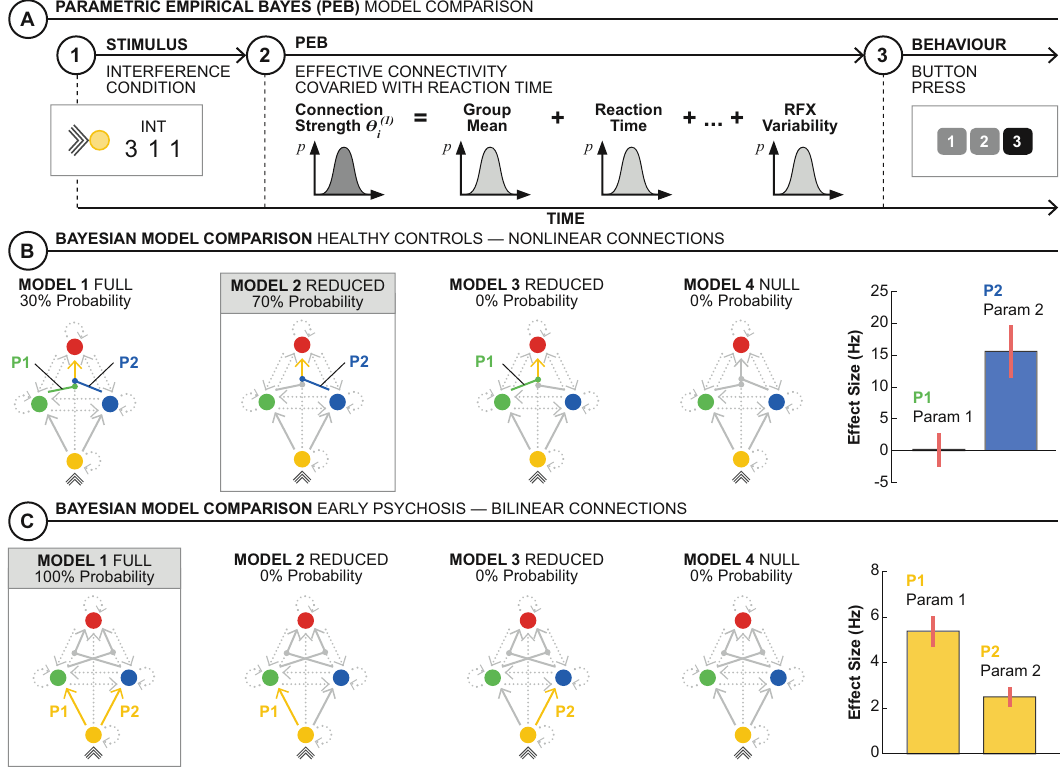
Fig. 3 Individual differences in effective connectivity and reaction time. A PEB was used to model the effect of interference condition on effective connectivity on the optimal model for each group (as derived from the BMS) and its dependence on reaction time (i.e., time from stimulus onset to button press) using a random-effects analysis. B For controls, the gated modulation of SPC on the VC to AI connection explained most of the individual differences in reaction time with a large effect size (posterior estimate 15.6 Hz). The reduced model containing this gated modulation was the most probable model to explain individual differences in reaction time (posterior probability 70%). C For EP participants, the linear, additive modulations from VC to ACC and VC to SPC explained most of the reaction time variance within group with moderate effect sizes (posterior estimate 5.4 Hz and 2.5 Hz, respectively). The full model containing both these linear, additive modulations was the most probable model to explain individual differences in reaction time (posterior probability